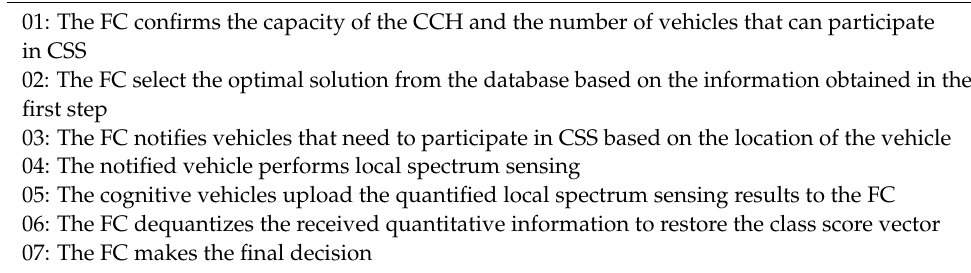
Algorithm 2 QBCSS in bandwidth-constrained CR-V2Xs based on DL